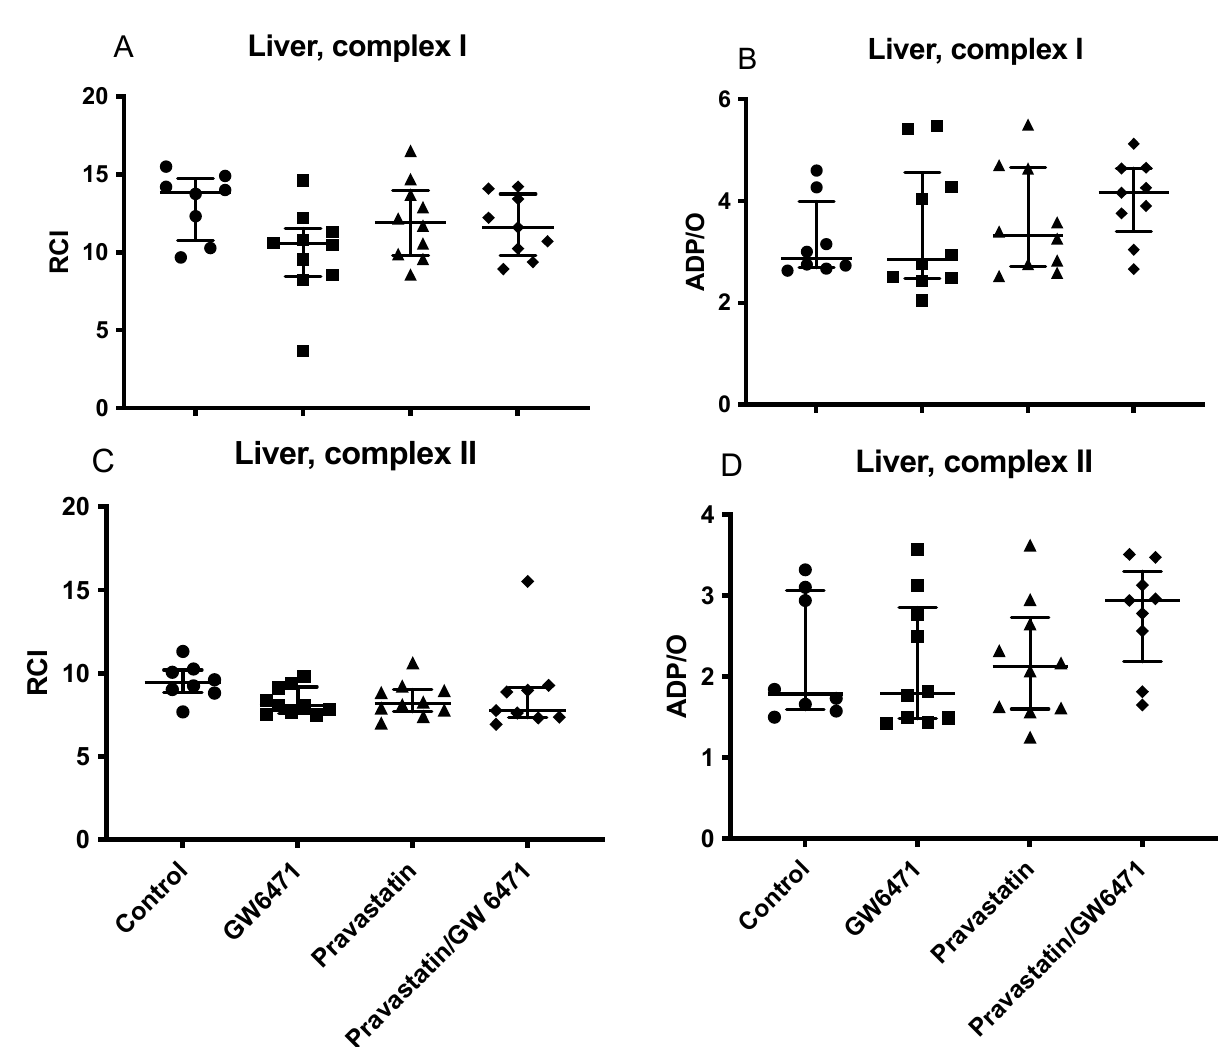
Figure 4. Effect of pravastatin, GW6471, and the combination of both on hepatic mitochondrial respiration: RCI (state 3/state 2) ( A , C ), (ADP/O = ADP added/oxygen consumed in state 3) ( B , D ). All mitochondrial parameters were analysed for complex I ( A , B ) and II ( C , D ). Data are presented as individual values, median with interquartile range n = 8–10.